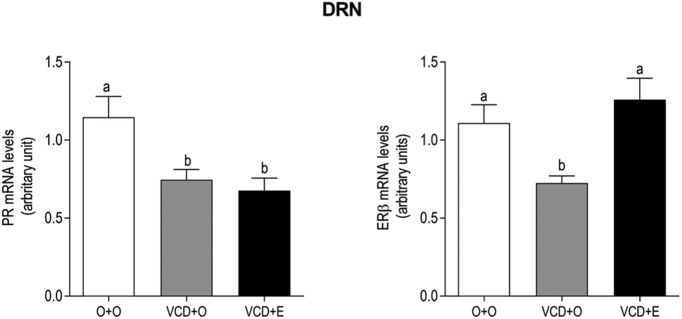
Effects of follicular depletion induced by VCD and chronic 17β-estradiol (E) administration on the relative mRNA expression of PR (left panel) and ERβ (right panel) in the DRN. Female rats at 28 d of age were subcutaneously injected with corn oil (O) or VCD for 15 consecutive days. Fifty-five days after the first injection of VCD/oil, rats received a subcutaneous capsule that contained corn oil (groups O + O and VCD + O) or 17β-estradiol (VCD + E). Rats were decapitated during the diestrous phase (O + O and VCD + O groups) or 21 d after the onset of E therapy (VCD + E), from 75 to 85 d after the onset of VCD/oil administration, between 9:00 and 11:00 A.M. (n = 6-9). Data are presented as the mean ± SEM. Significance was accepted at p < 0.05.